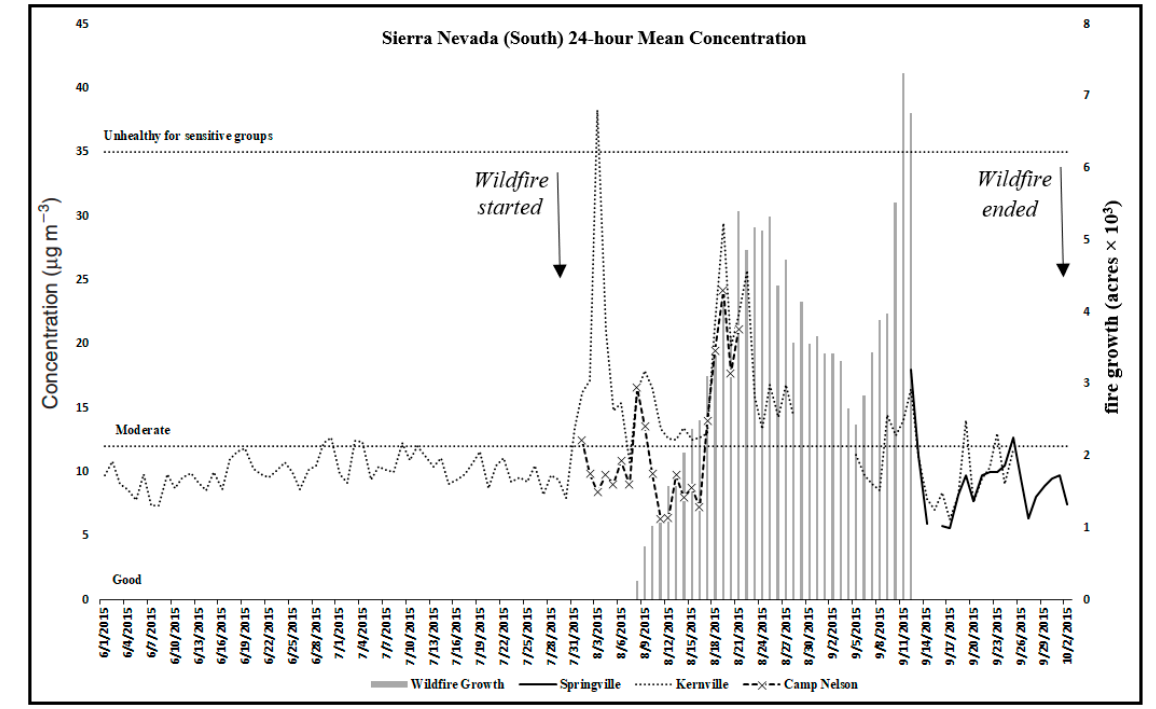
Figure 6. 24-Hour PM 2.5 concentrations with Air Quality Index (AQI) breakpoints for monitoring sites. Note: no daily fire growth data were available at the beginning of the fire.